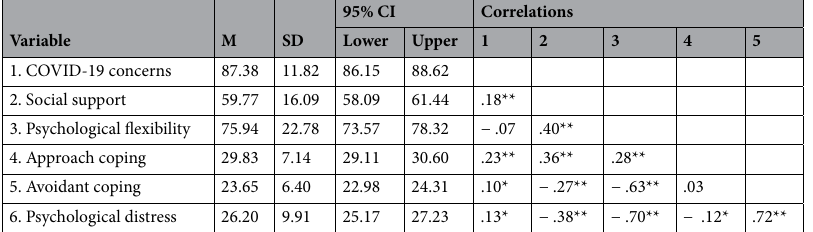
Table 1. Descriptive statistics for each variable in the path analysis and bivariate Pearson correlations between each variable. * p < 0.05; ** p < 0.01.